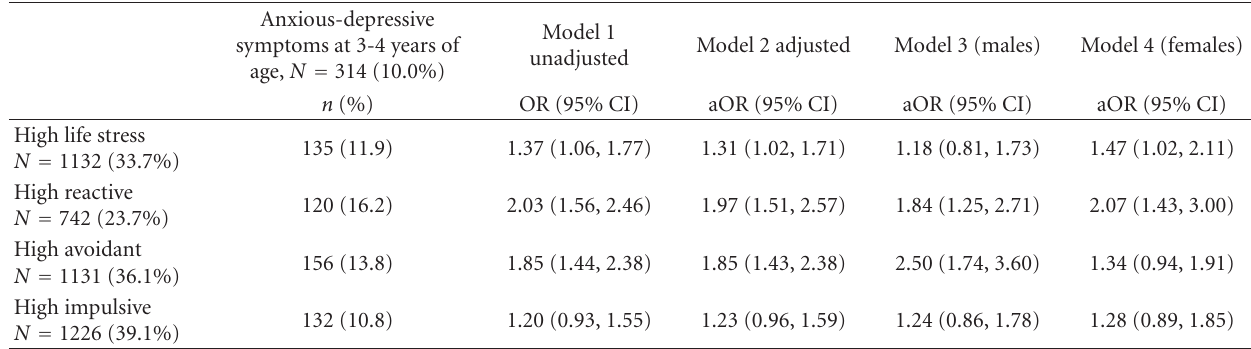
Table 2: Summary of logistic regression analysis predicting anxiety and depressive symptoms in 4 year old